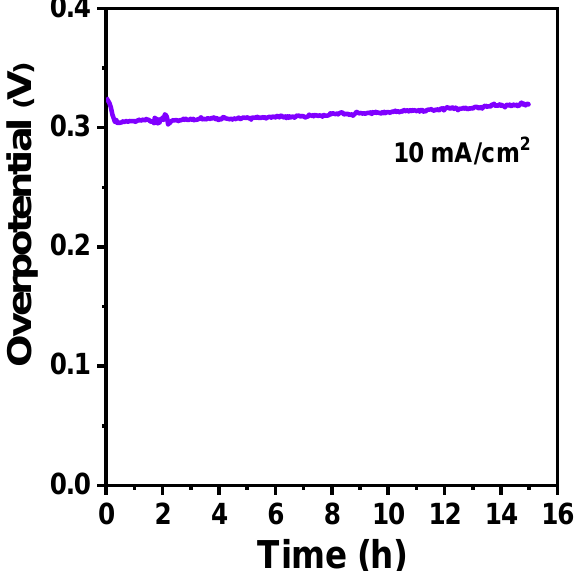
Figure 7. Chronopotentiometric measurement for the long-term stability test of the FeS 2 / C catalyst at the current densities of 10 mA / cm 2 .